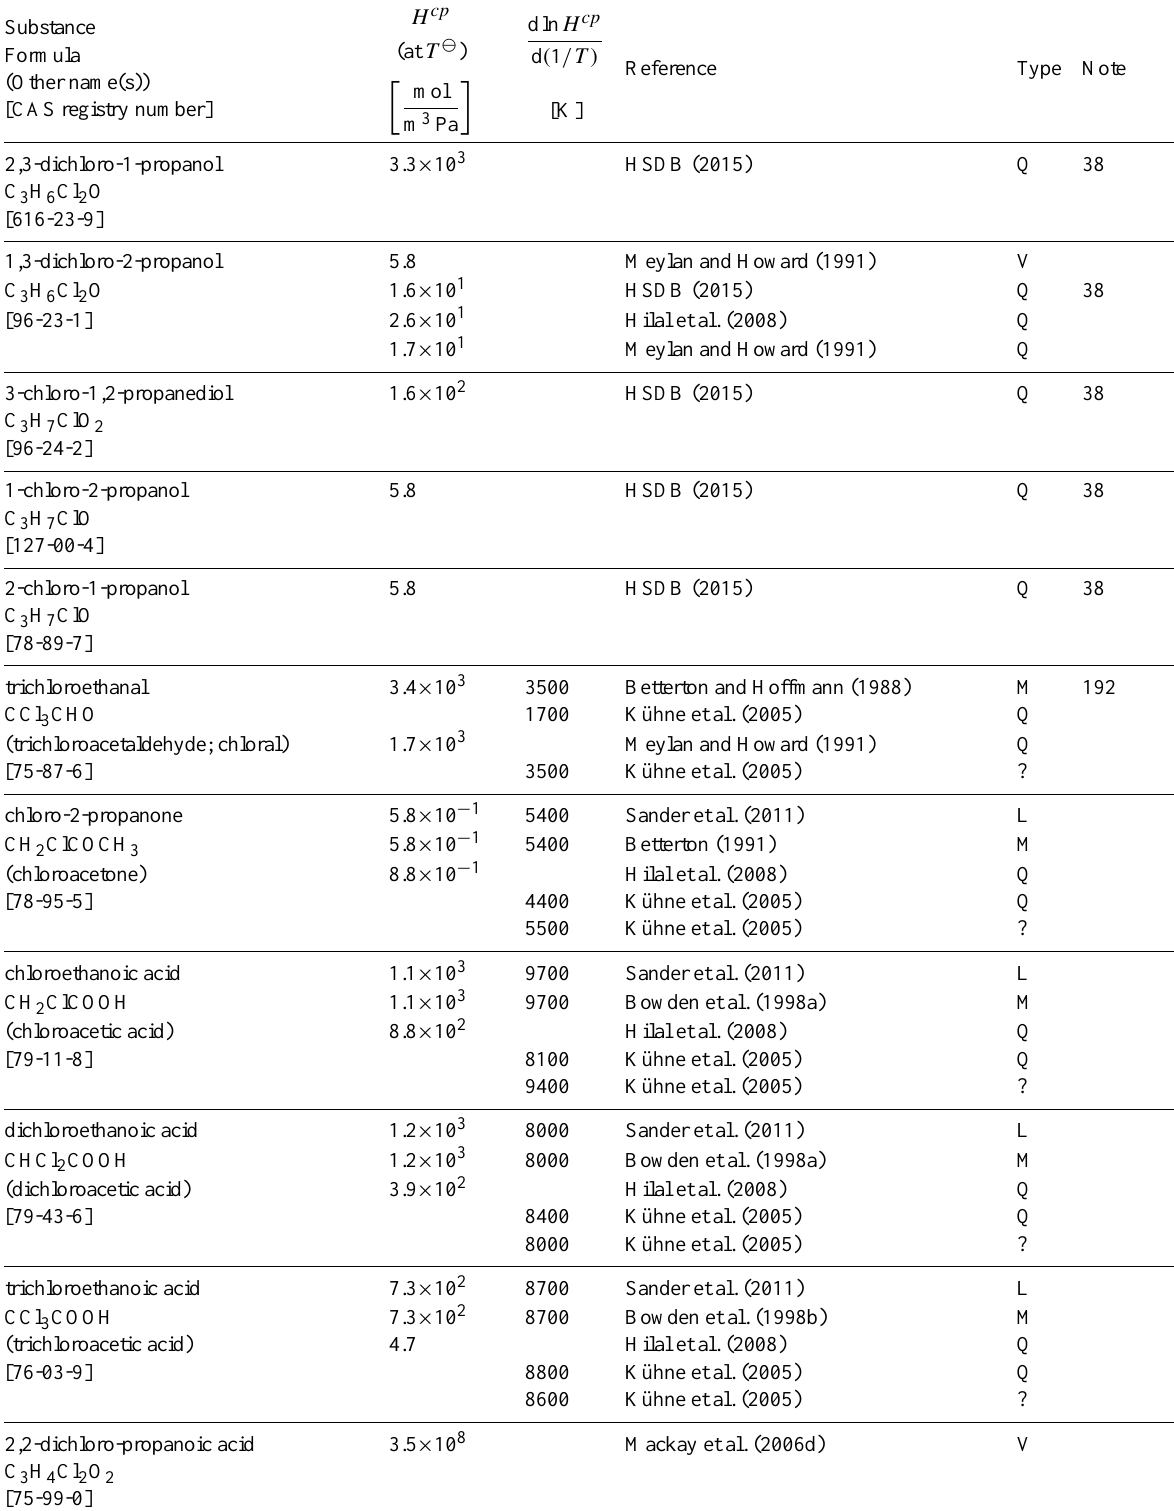
Table 6: Henry’s law constants for water as solvent